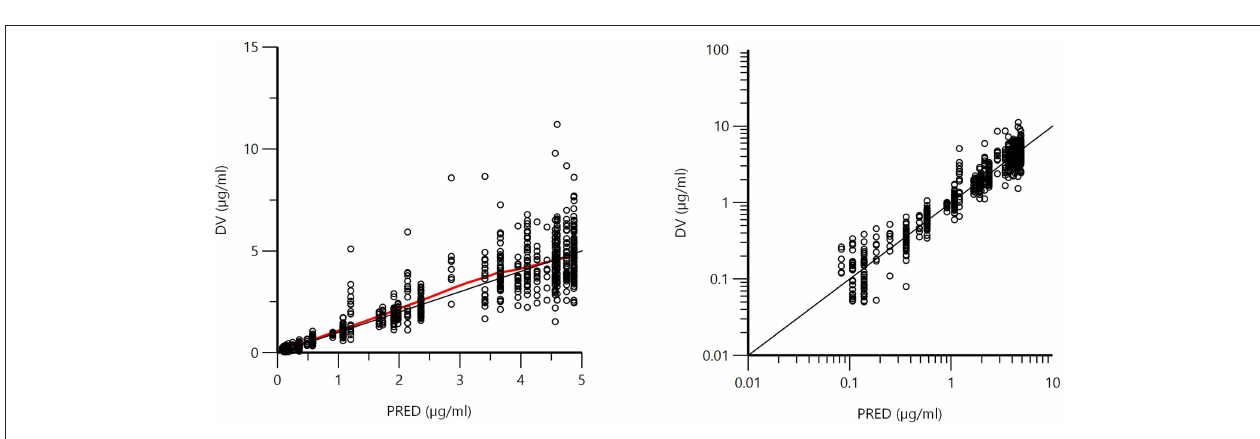
FIGURE 2 | Plot of the dependent variable (DV) i.e., plasma florfenicol concentration ( µ g/ml) vs. population predicted plasma florfenicol concentrations (PRED) (no random component). The plot illustrates observed vs. fitted values of the model function. Ideally, they should fall close to the line of unity y = x. Arithmetic scale (left) and logarithmic scale (right) . For both arithmetic and logarithmic scales, data were evenly distributed about the line of identity, indicating no major bias in the population component of the